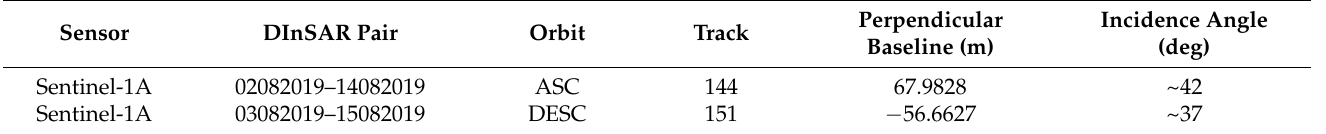
Table 1. Main characteristics of the interferometric pairs considered for the performed modeling.